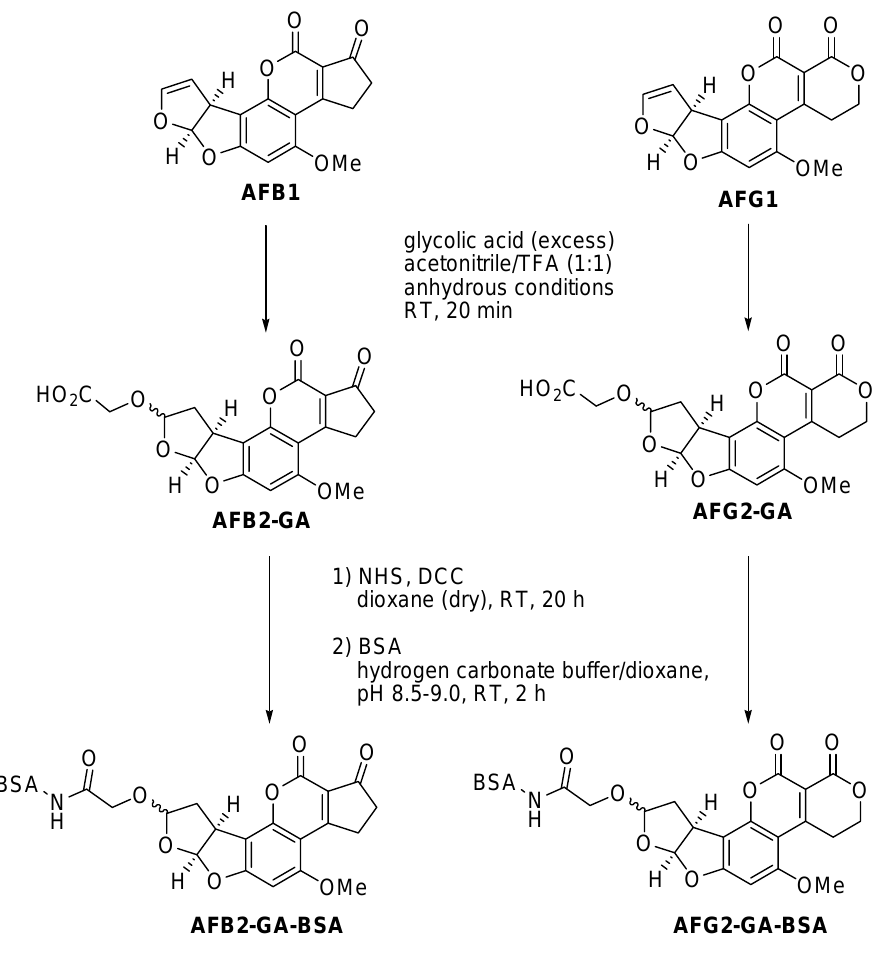
Figure 3. Conversion of AFB1 and AFG1 to AFB2-GA and AFG2-GA and subsequent coupling to BSA via N -hydroxysuccinimide-ester